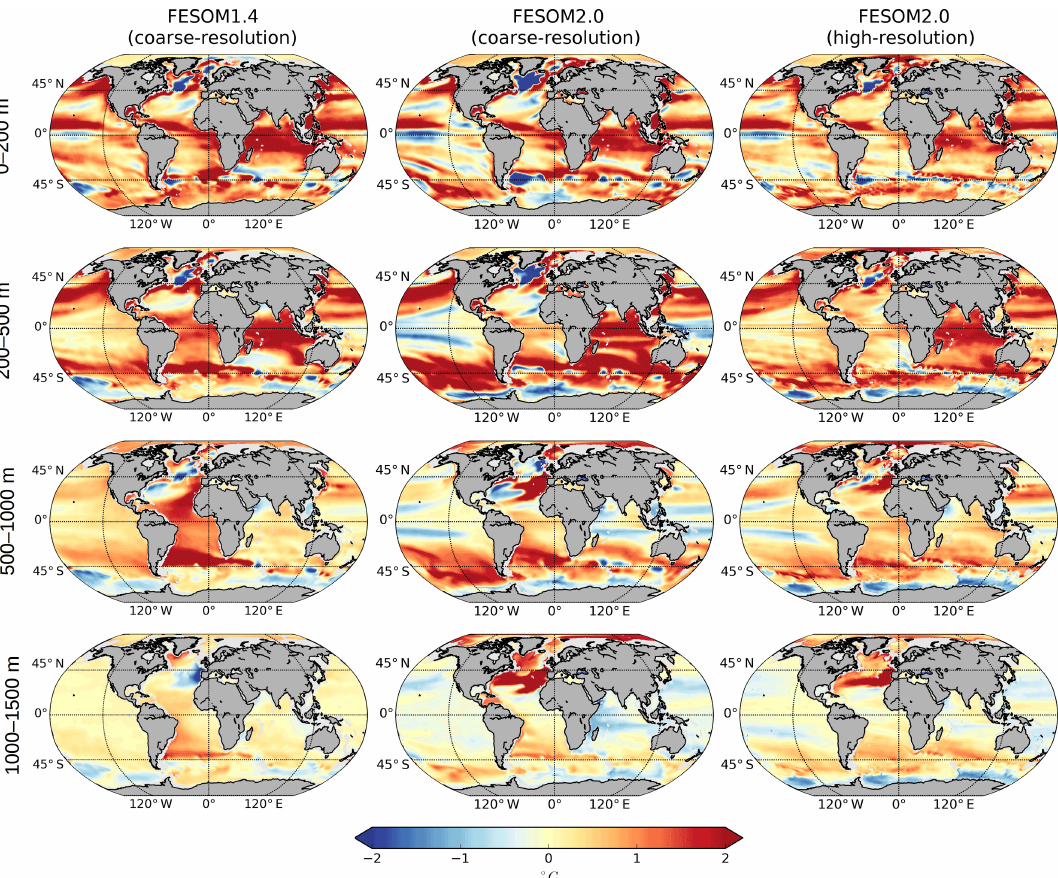
Figure 3. The departure of simulated potential temperature averaged over 1998–2007 from WOA2005 climatology, averaged over depth ranges. The left and middle columns correspond to the simulations performed with FESOM1.4 and FESOM2, respectively, on the coarse- resolution reference mesh. The right column corresponds to FESOM2.0 on the global mesh with a resolution of 15km (no GM parameteri- zation is used in this